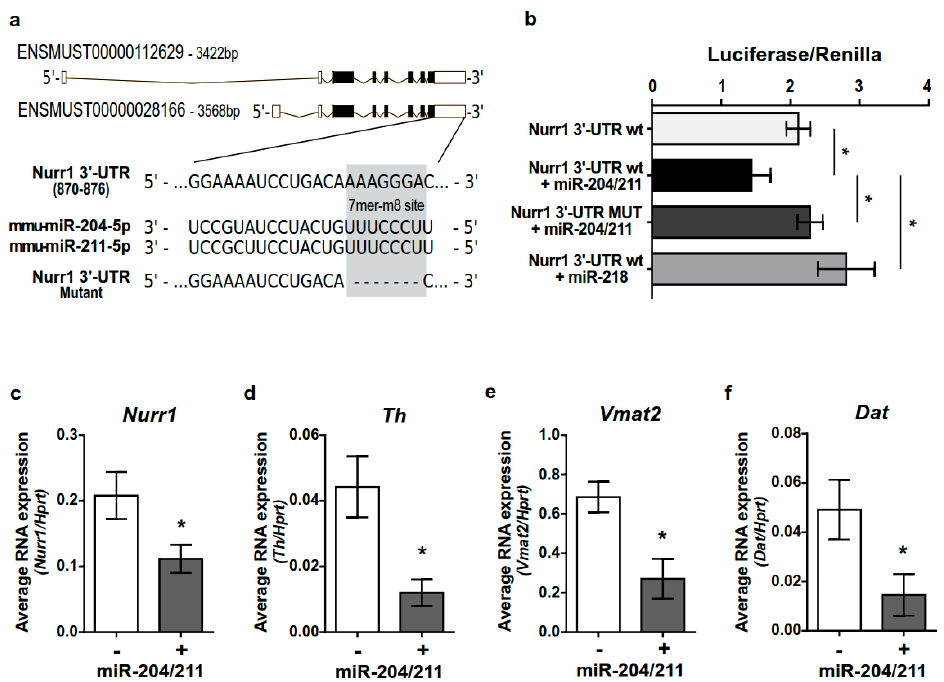
Figure 5. miR-204/211 targets Nurr1 3 ′ UTR and its expression/activity in differentiating mDAn. ( a ) Schematic representation of miR-204/211 binding site on wild-type (wt) mouse Nurr1 3 ′ UTR. The two existing Nurr1 transcript variants have the same 3 ′ UTR and conserve an identical miR-204/211 binding site. The mutated sequence was also reported. ( b ) Luciferase assay on pMIR-Report construct containing the wt or MUT Nurr1 3 ′ UTR downstream to the luciferase gene and transfected in HeLa cells, alone or in combination with miR-204/211 or miR-218. Data represent the mean ± SD of the ratio luciferase/renilla of three independent experiments. * p < 0.05 (one-way ANOVA + Tukey post-hoc). ( c – f ) qPCR for Nurr1, Th, Vmat2, and Dat on differentiated mes-c-myc-A1 overexpressing the miR-204/211. Data represent the mean ± SD of 2 −Δ Ct values from three independent experiments. * p < 0.05 (unpaired t-test with Welch’s correction).